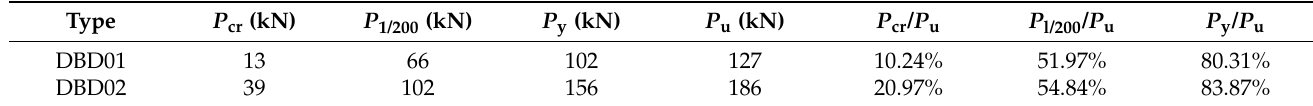
Table 4. Characteristic load of sandwich laminated floor slab.